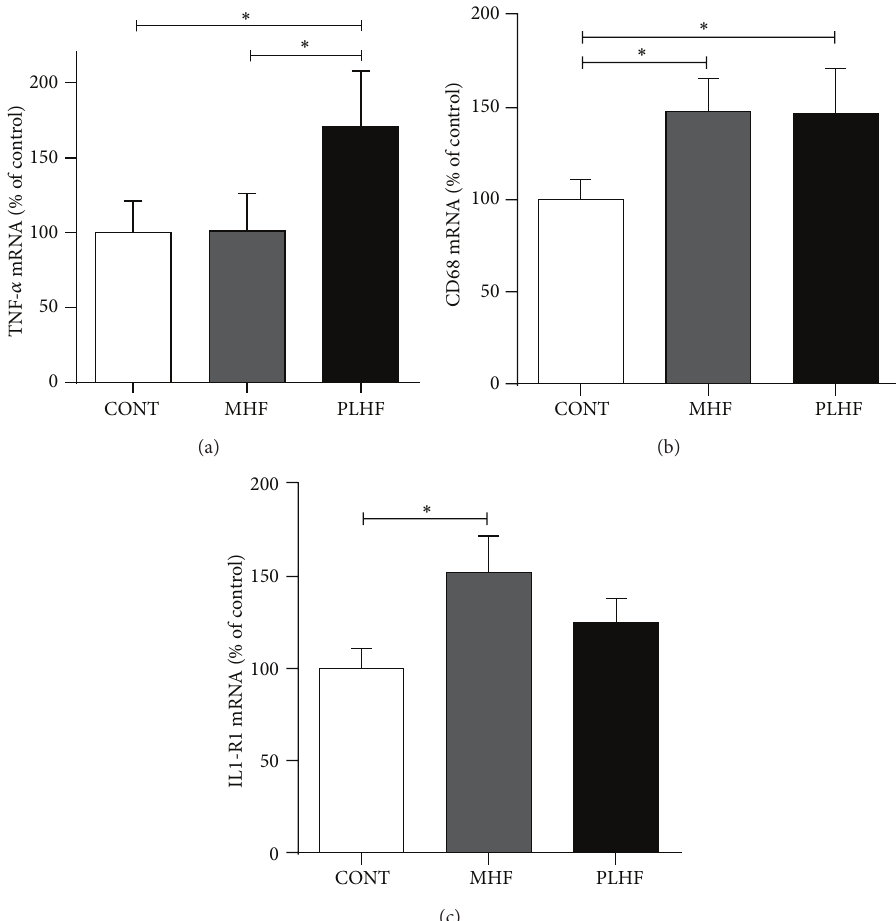
Figure 6: Pancreatic mRNA expression of TNF- 𝛼 (a), CD68 (b), and IL1-R1 (c) in adult CONT, MHF, and PLHF offspring. TNF- 𝛼 ; tumor necrosis factor-alpha; CD68: cluster of differentiation 68; IL1-R1: interleukin 1 receptor, type 1. Data are means ± SEM, 𝑛 = 10–18 per group. ∗ 𝑃 < 0.05